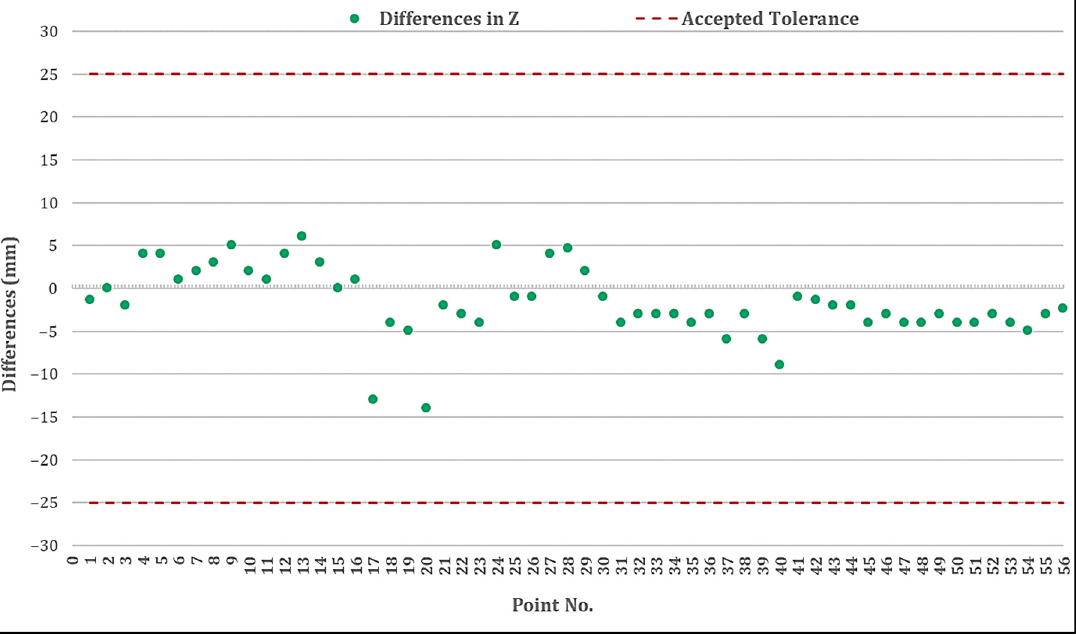
Figure 9. Differences between the extracted points by the proposed method and known coordinates on the Z axis of the first test.